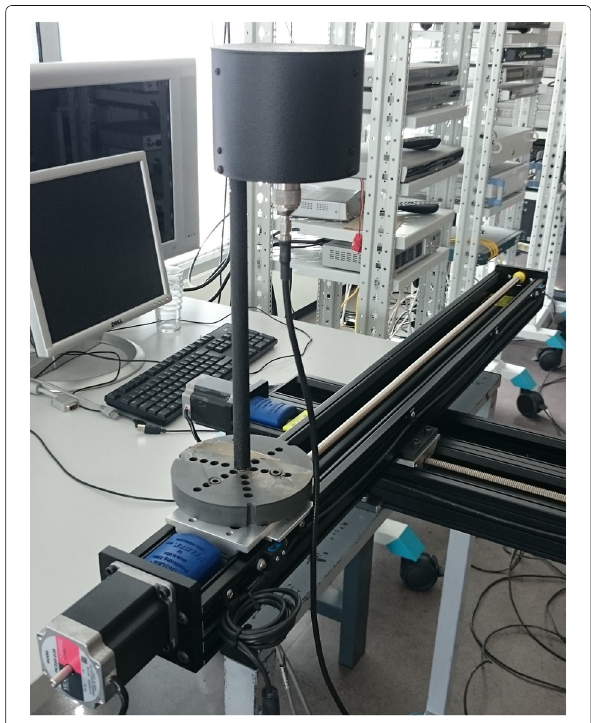
Fig. 13 Automated positioning system and UWB antenna, to form a planar horizontal virtual